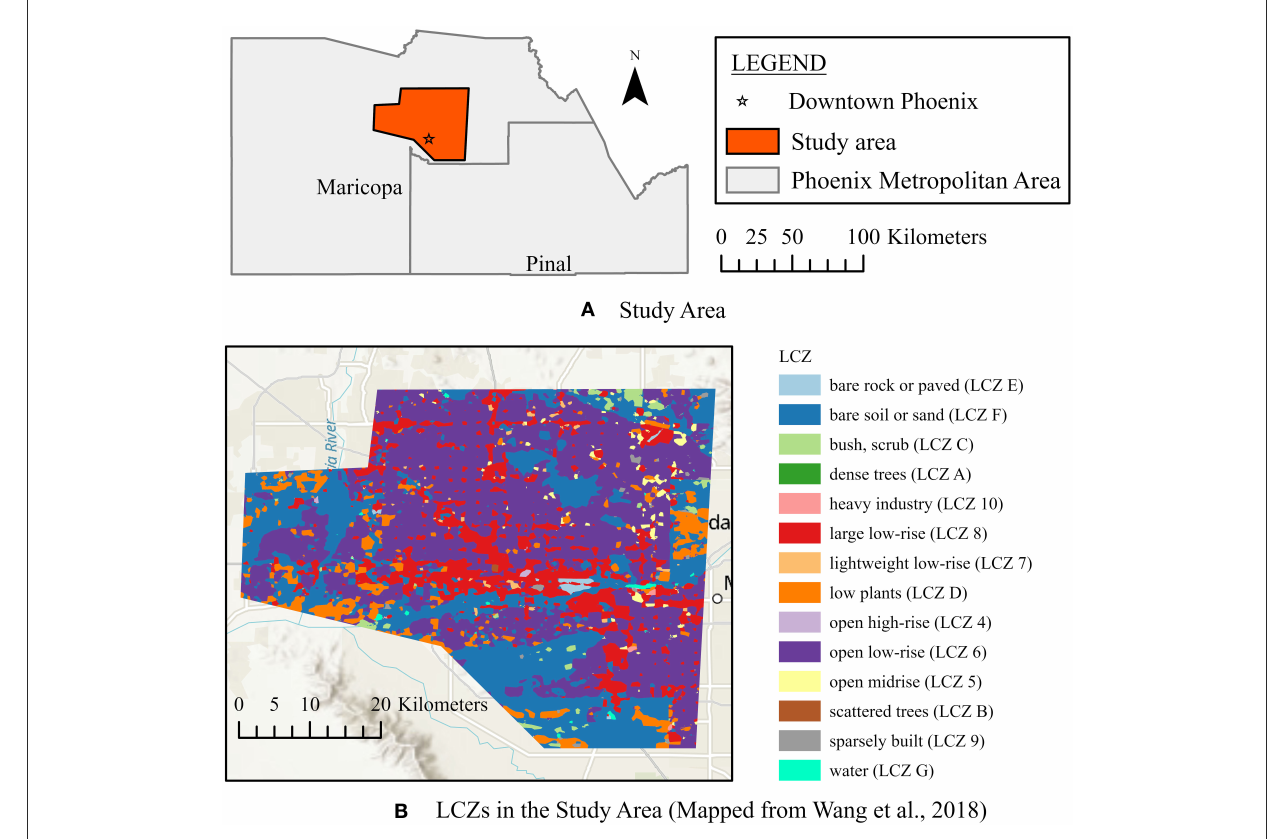
FIGURE2 Study area (A) and the LCZs in the study area (B)